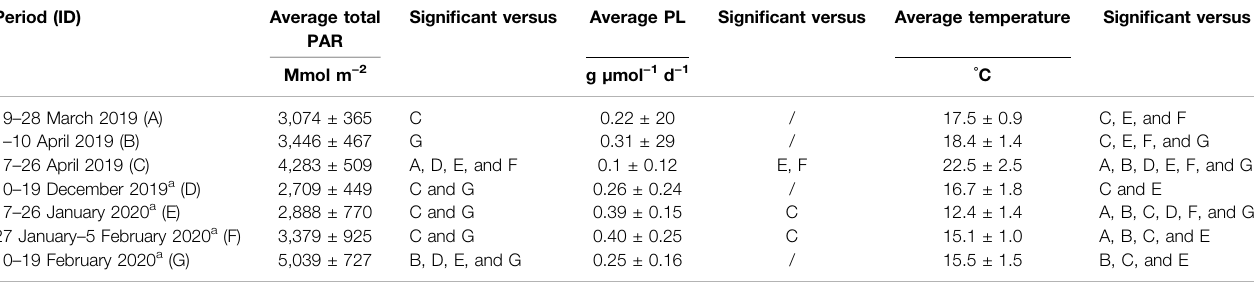
TABLE2| AveragetotalPAR,averagedailyyieldinlight(P L )foreachgrowthperiod,andgreenhousetemperaturesmeasuredduringthebatchtests.Asigni fi cancebetween groups is also shown with p < 0.05. The identi fi er is used to show the signi fi cant differences between periods. Period (ID) Average total